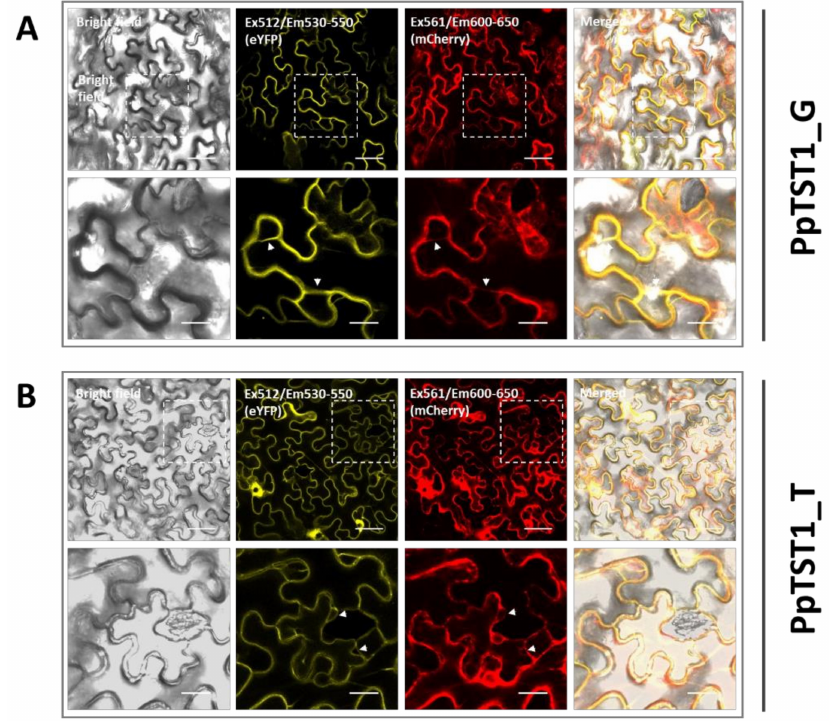
Figure 4. The subcellular localization of PpTST1 in tobacco leaves. Co-expression of pMDC83-eYFP- PpTST1_G ( A ) and pMDC83-eYFP-PpTST1_T ( B ) with tonoplast marker vac-rk CD3-975 in bright field, YFP channel, mCherry channel, and merged channel, respectively. Bottom lane are the enlarged images of the upper lane. The white arrow indicates vacuole membrane. Upper and bottom lane scale bars are 50 and 20 µ m,